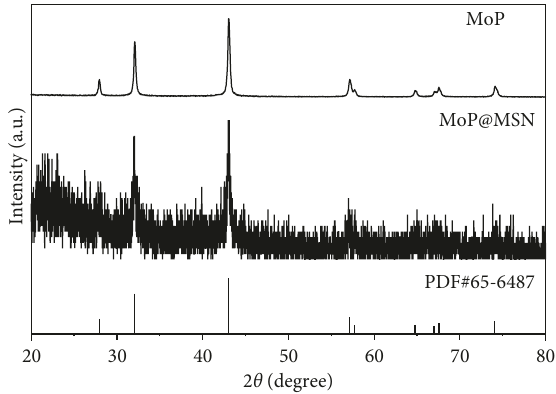
Figure 1: XRD patterns of MoP and MoP@MSN.